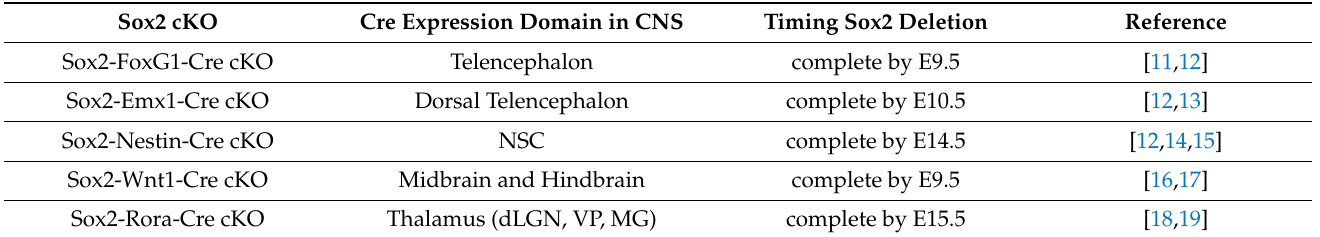
Table 1. Timing and location of Sox2 deletion in different Sox2 conditional knock-outs (cKO). Sox2 cKO Cre Expression Domain in CNS Timing Sox2 Deletion